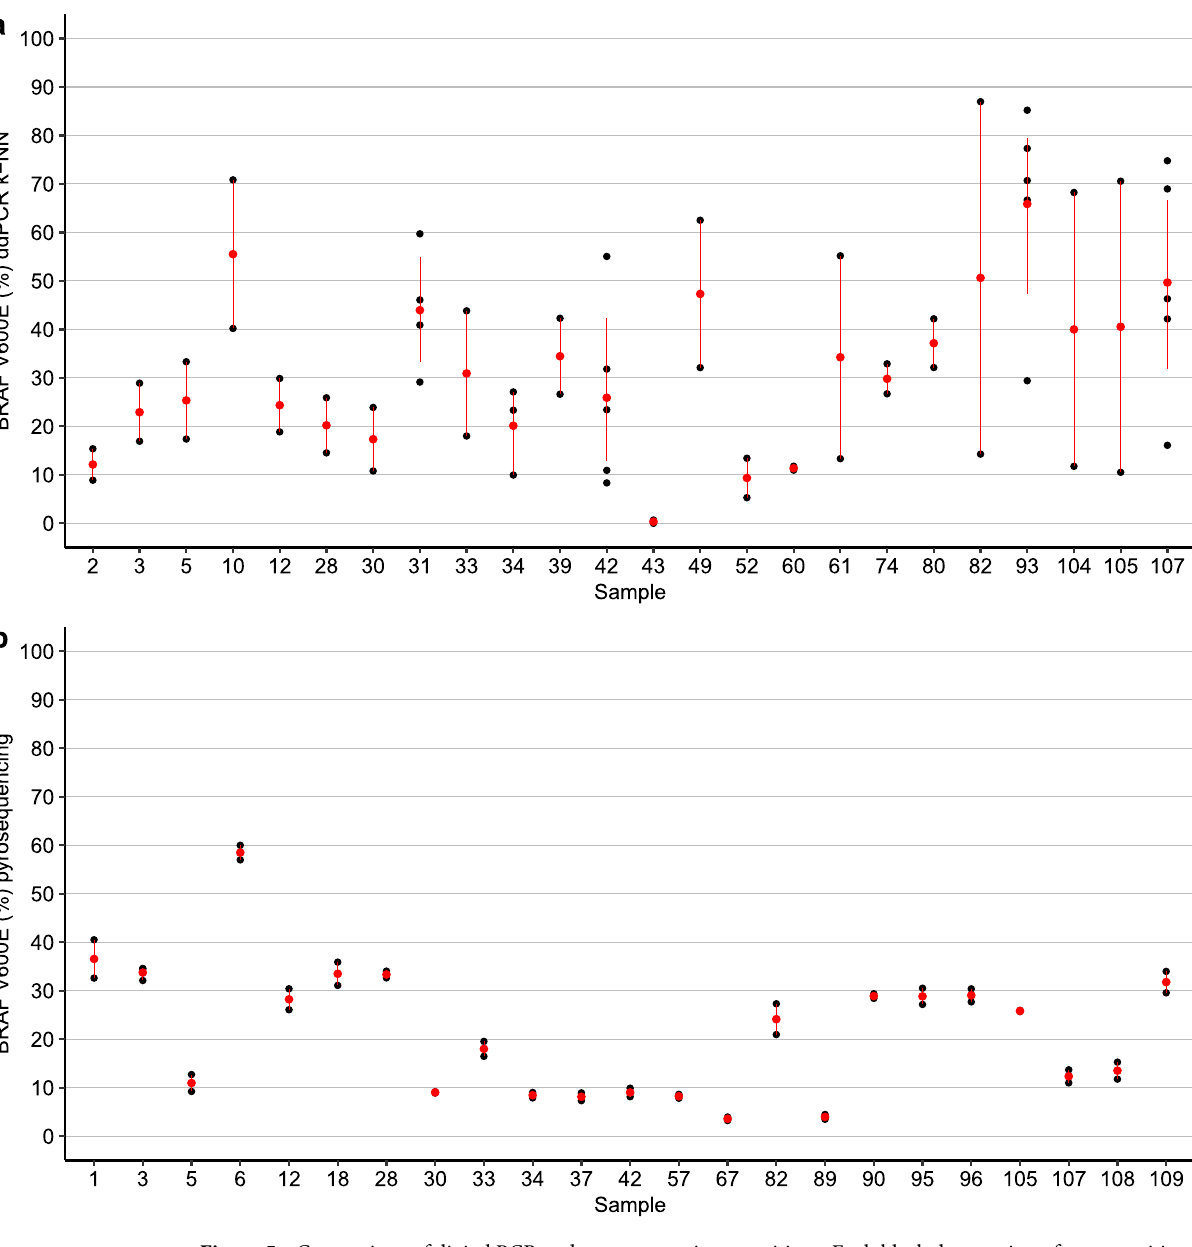
Figure 5. Comparison of digital PCR and pyrosequencing repetitions. Each black dot consists of one repetition, the red dot is the mean value of repetitions and the red line represents the standard deviation. ( a ) Digital PCR percentage of BRAF V600E when using k-NN classification method with rain. The repetitions, in general, have a high variability. The mean of the standard deviation of each repetition is 10.62. Adopting the threshold of 9.82% mutated alleles, some samples are considered positive or negative depending on the repetition. This is true for samples 52, 2, 42 for example. ( b ) Pyrosequencing BRAF V600E percentage. Overall, any sample repeated in pyrosequencing was very close to one another in terms of BRAF V600E VAF. The mean of the standard deviation of each repetition is 1.32, which is very low. Additionally, only one sample, with the highest value of the repetition being 9.9%, changed classification of positive or negative based on the threshold of 9.82%.